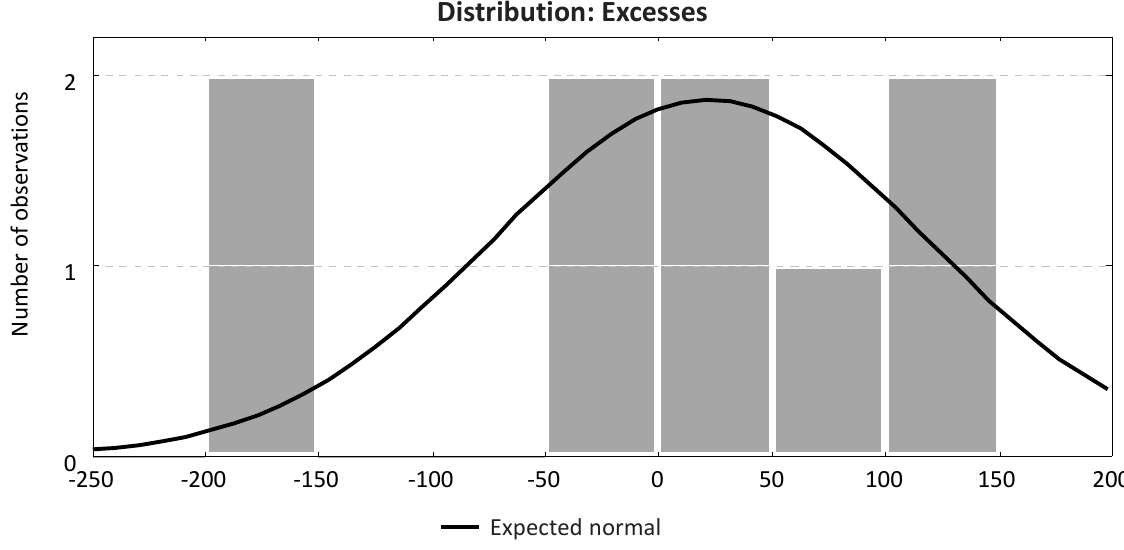
Figure 1. Distribution of excesses for the regression of standard deviation of the size of the Deposit Guarantee Fund ( ) y from its volume ( ) x the volume of the fund ( ) x (the function of the first constraint) are shown in Table 3 and Figure 2.